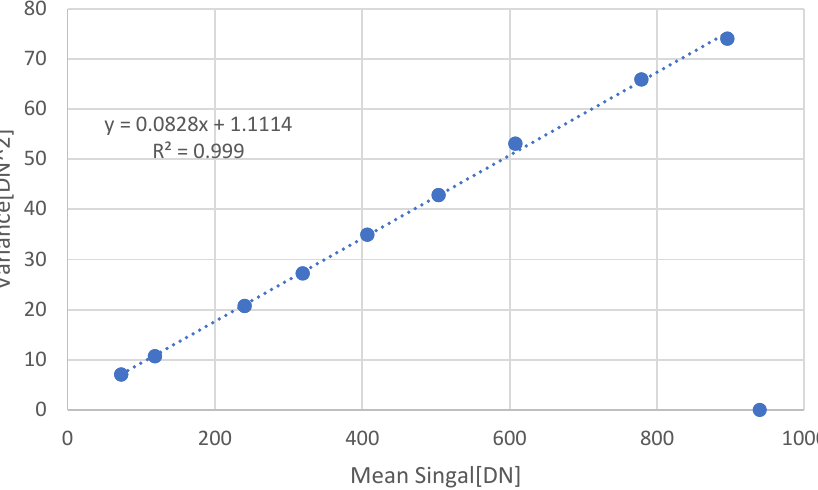
Figure 5. Conversion Gain measurements using the Mean-Variance method under illumination at 550 nm. The slope is 0.0828 [DN/e], leading to a Conversion Gain value of 6 [e/DN] using Model Case I.